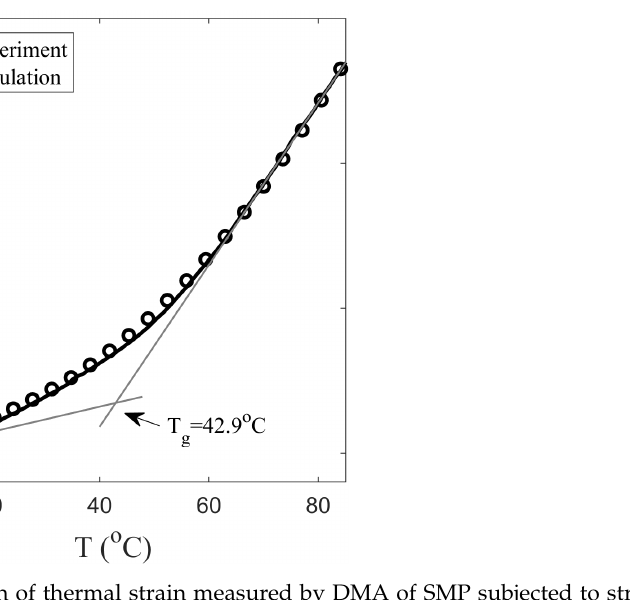
Figure 3. Evolution of thermal strain measured by DMA of SMP subjected to stress-free cooling at 4 °C/min.